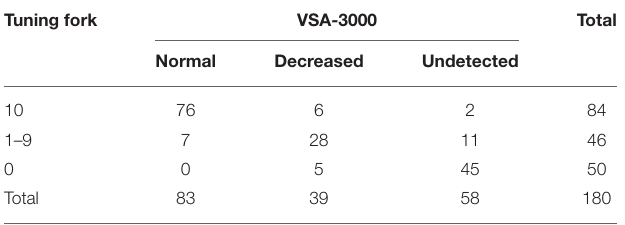
TABLE 5 | Consistency for tuning fork and VSA-3000.